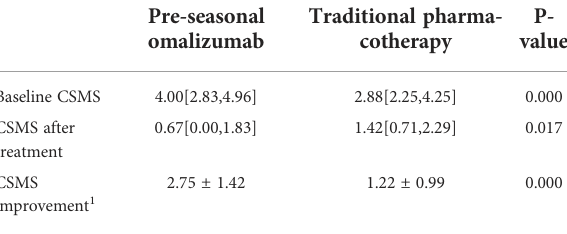
TABLE 3 Pre-seasonal omalizumab is more effective than traditional